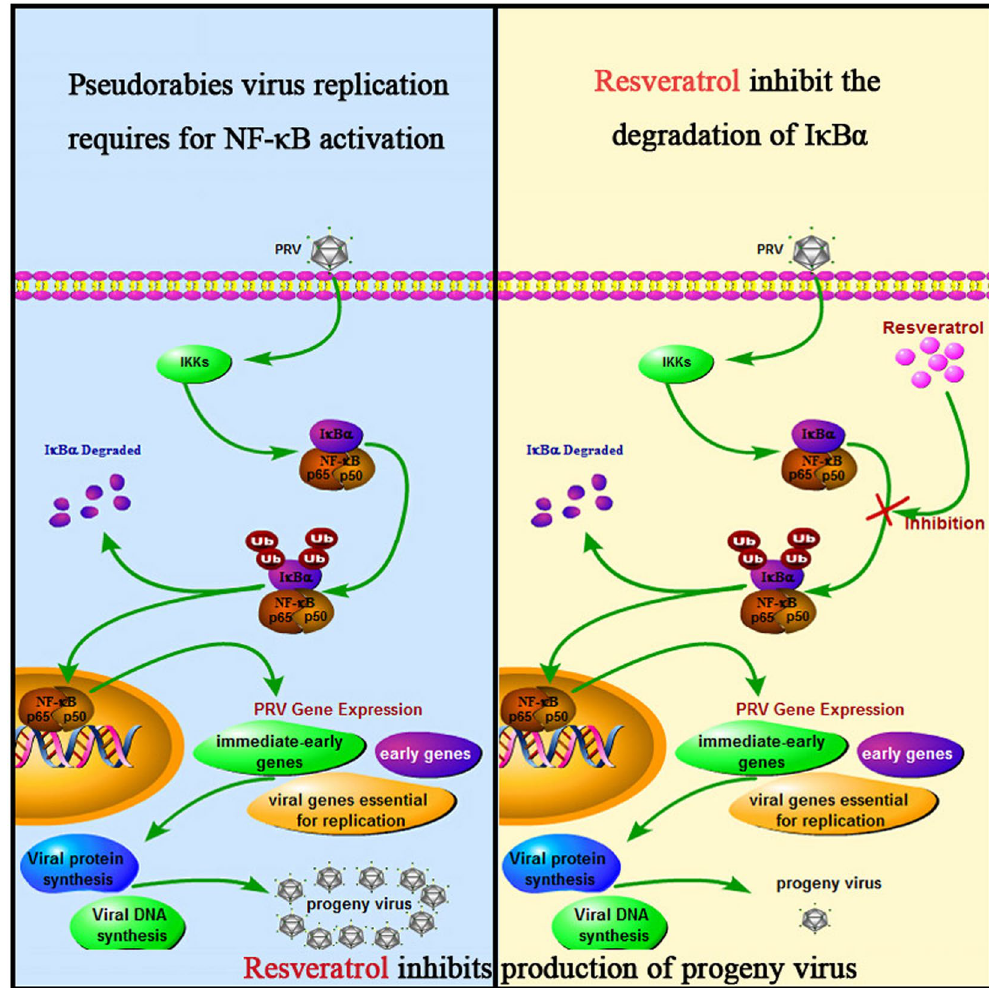
Figure 7. Schematic presentation of the Res anti-PRV molecular mechanism. The antiviral mechanism of Res against PRV attributes to inhibiting the degradation of I κ B α kinase. Res could then block the expressions of NF- κ B-dependent genes that would potentiate progeny virus